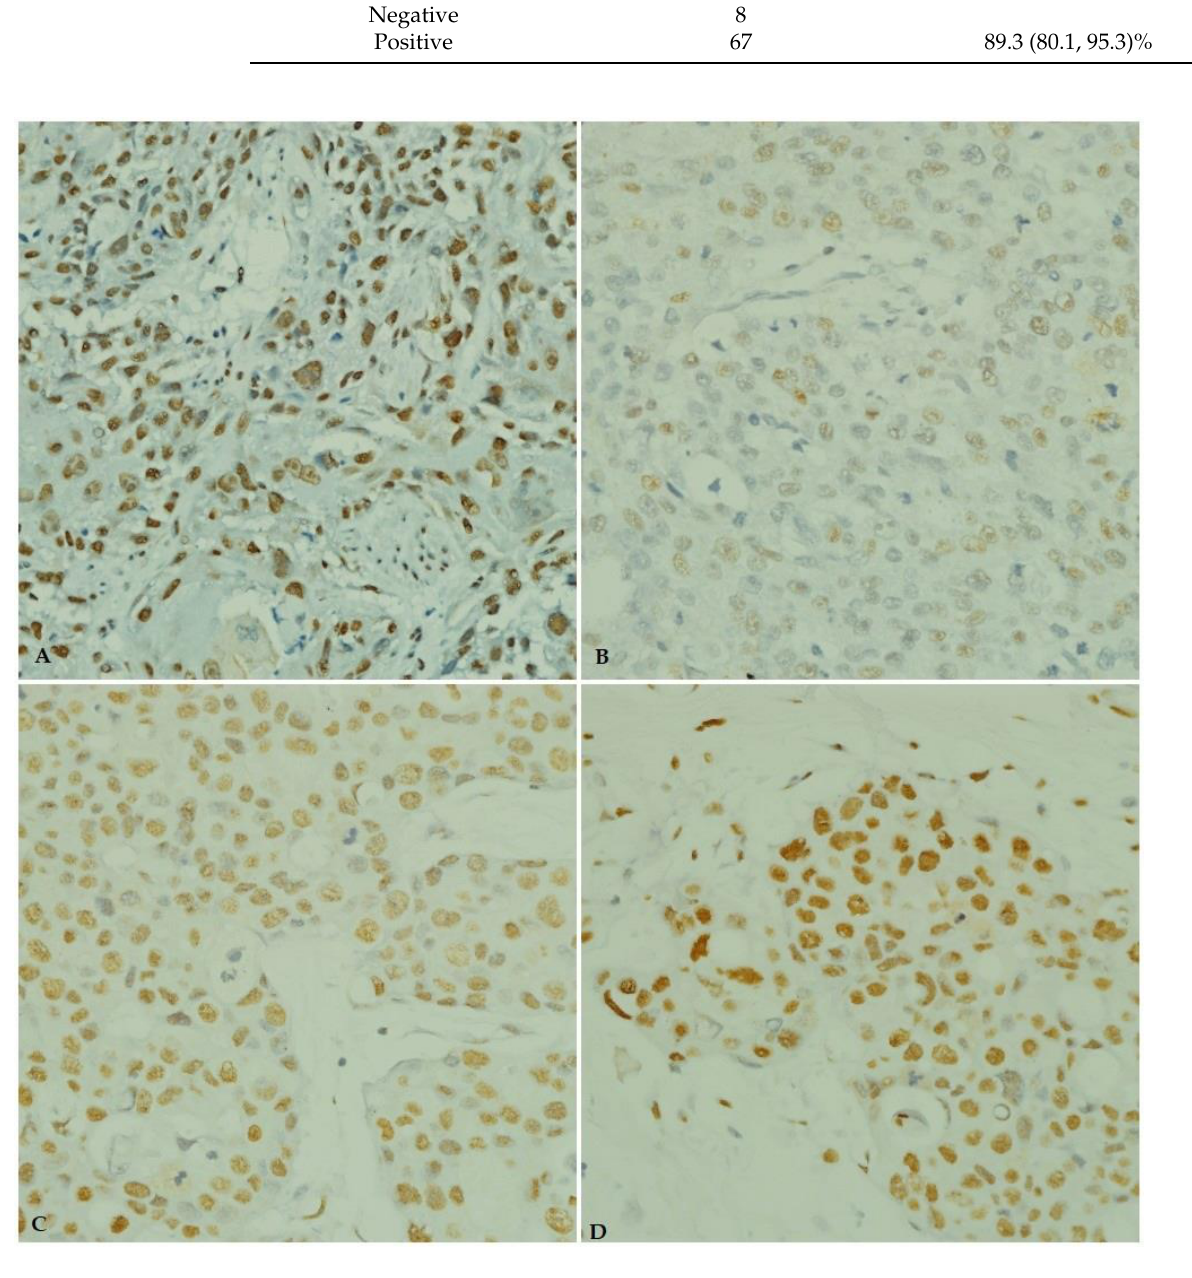
Figure 4. Immunohistochemical staining of ANGPTL4 in breast carcinoma tissue from young patients. ( A ) ANGPTL4 positive control (esophageal squamous cell carcinoma, × 40). ( B ) Weak ANGPTL4 immunostaining. ( C ) Moderate ANGPTL4 immunostaining ( × 40). ( D ) Strong ANGPTL4 immunostaining ( ×